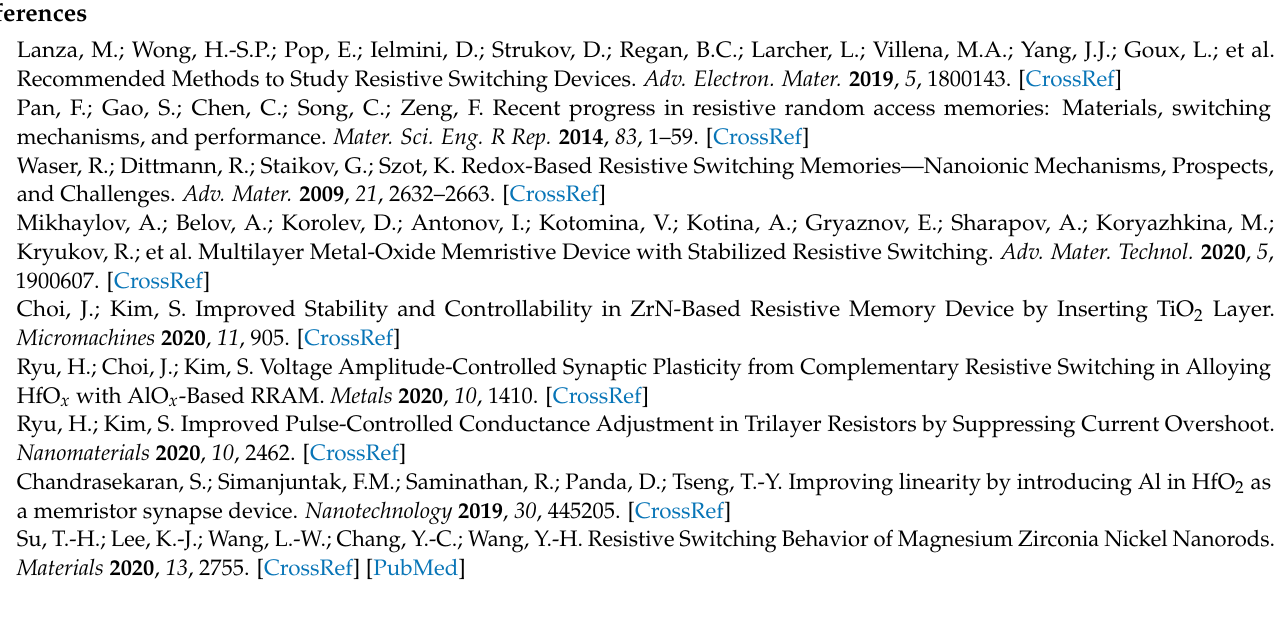
Figure 6. ( a ) Two-layered neural network configuration. ( b ) Accuracy as a function of the epoch.